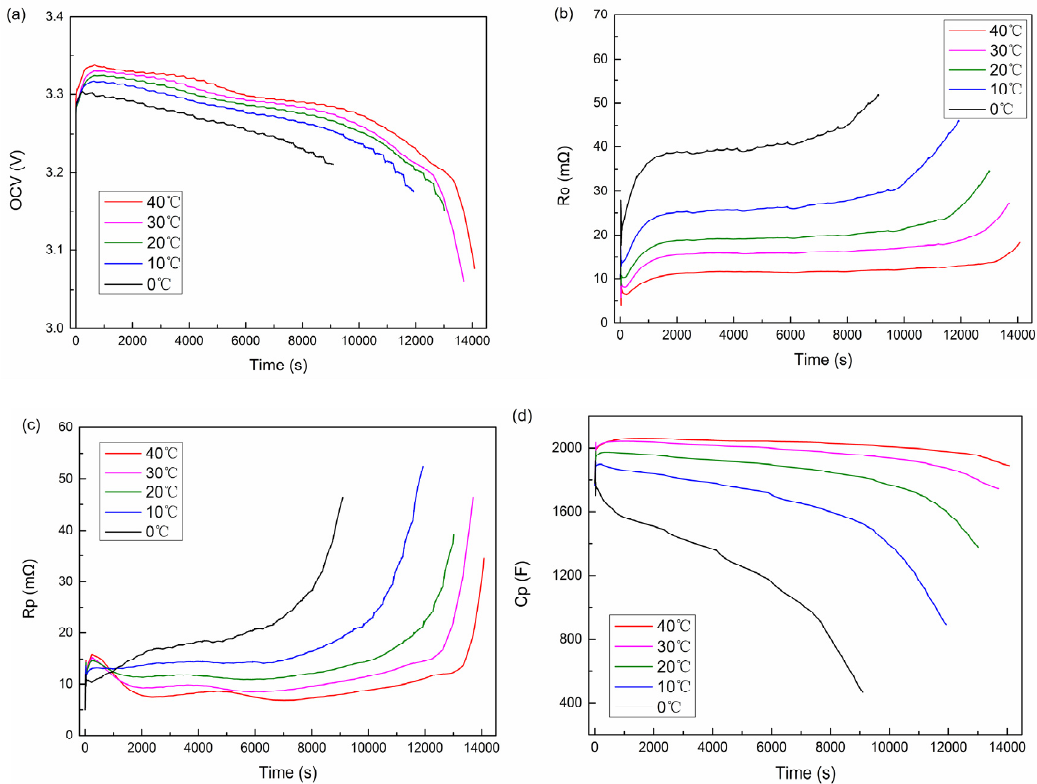
Figure 9. Online parameter estimation results for the DST test from 0 °C–40 °C: ( a ) OCV; ( b ) R O ; ( c ) R P ; and ( d ) C P